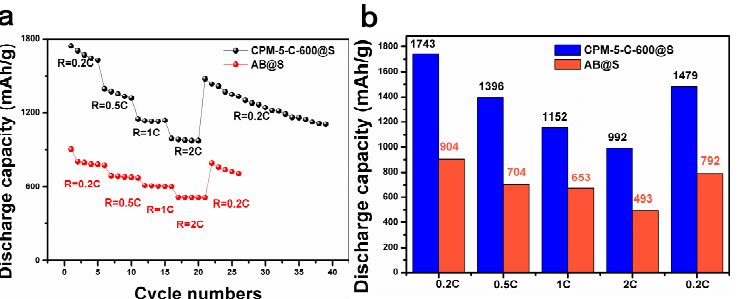
Figure 8. ( a , b ) C-rate performance for CPM-5-600@S and AB@S cathodes at various C-rate from 0.1 C to 2 C.